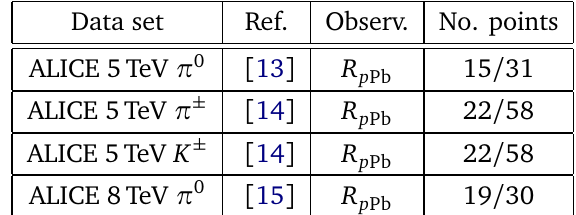
Figure 1: Comparison of different scale choices for predictions of p + p → π 0 + X shown as the ratio of theory over data for PHENIX [ 7 ] in the upper panel and ALICE [ 8 ] in the lower panel. The theory predictions are calculated using nCTEQ15 proton PDFs with DSS FFs. Table 1: Overview of the available data sets and number of data points after / before